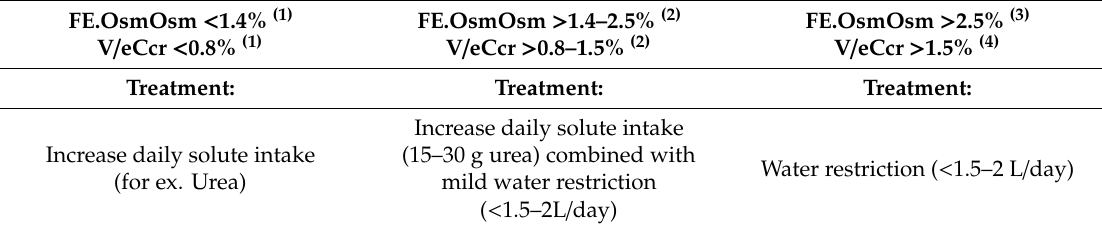
Table 4. Suggested therapeutic implication of the measurement of FE.OsmOsm (%) and V / eCcr (%) in chronic hyponatremia related to